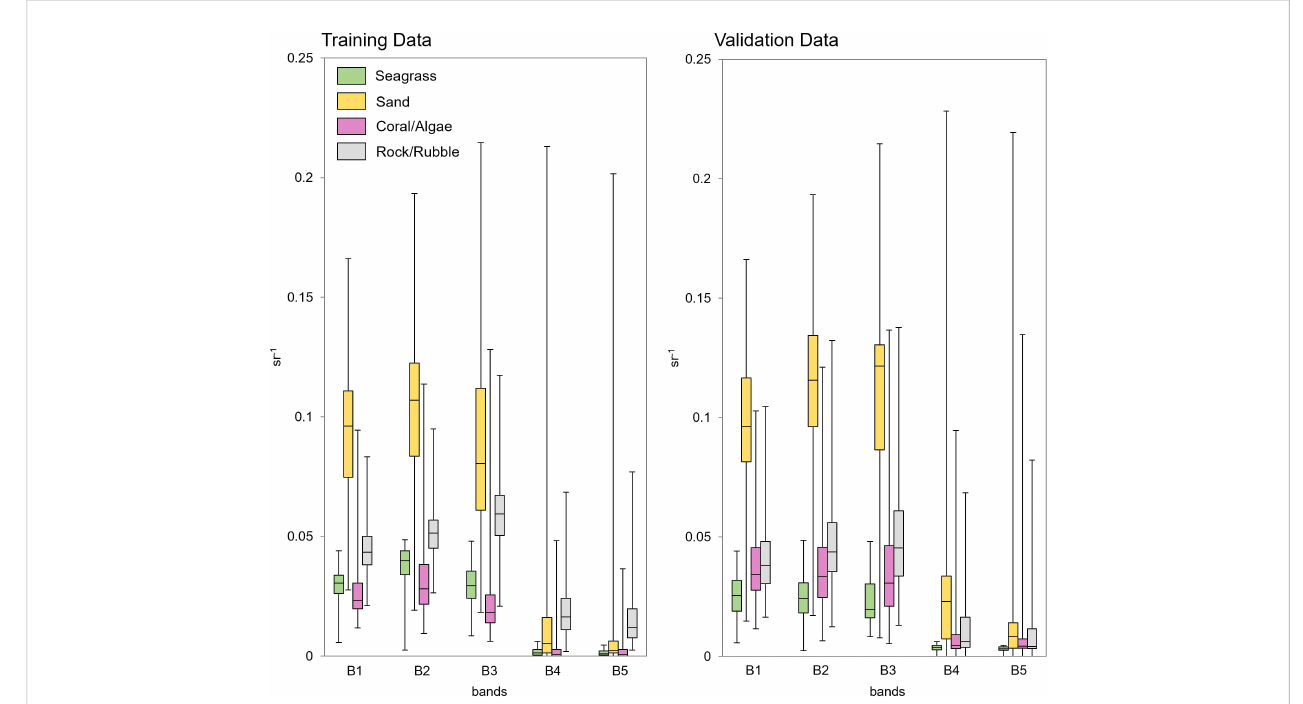
FIGURE 2 Spectral ranges of the training and validation data for the fi rst fi ve multi-temporal Sentinel-2 below-surface re fl ectance (r rs ) bands. [sr -1 ] denotes the unit of the below-surface remote sensing re fl